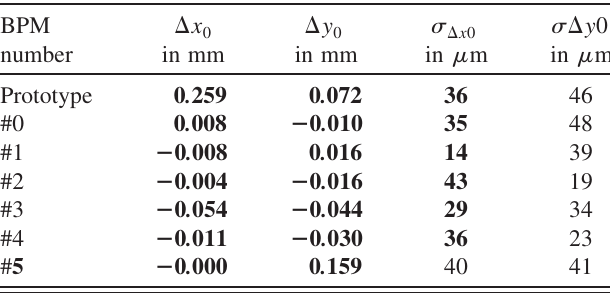
TABLE V. Intrinsic offsets for each BPM. These values are the result of 16 measurements with a complete dismount and re- mount of the BPM block. The typical sigma value is 35 (cid:2) m rms.